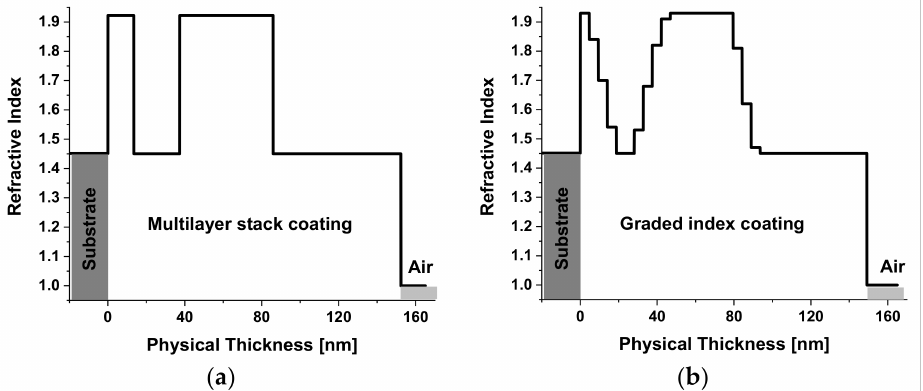
Figure 14. Refractive index profile of ( a ) multilayer stack and ( b ) graded index antireflection coatings at 355 nm.